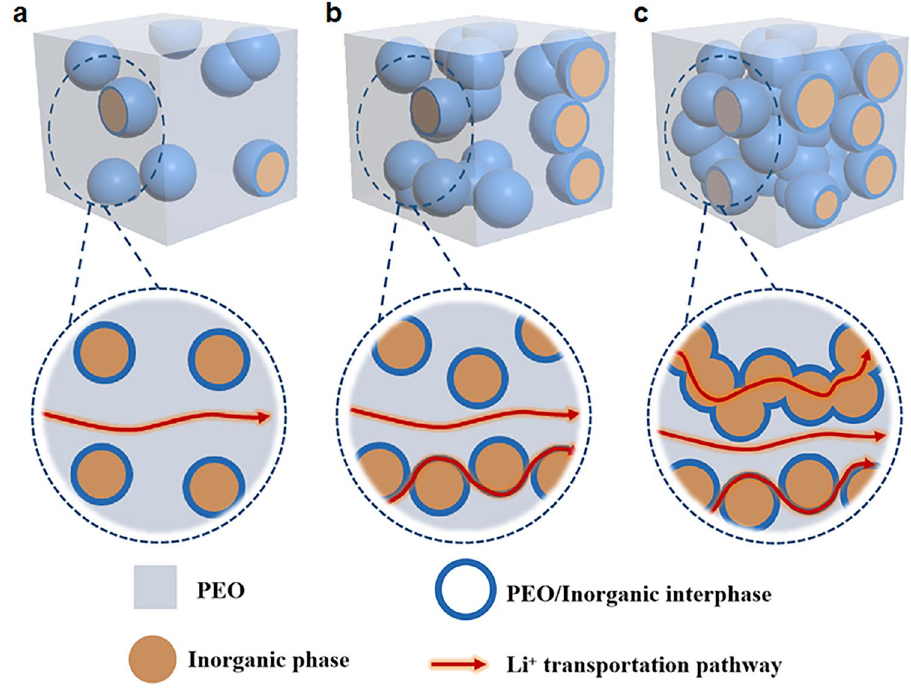
Fig. 2 Schematic illustration of the Li + conduction pathways a in the PEO phase, b in the PEO phase and at PEO/ceramic interface, and c in the PEO phase and ceramic phase and at PEO/ceramic